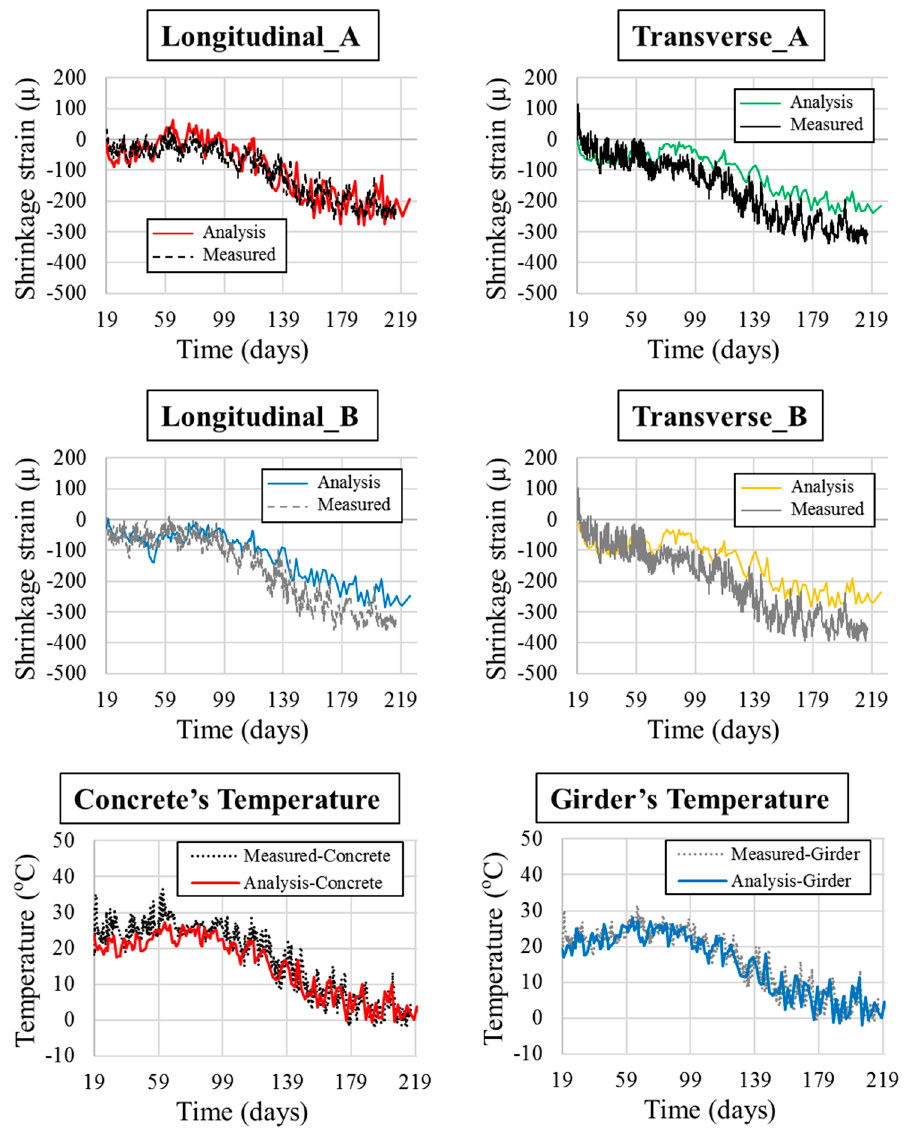
Figure 22. Concrete shrinkage strain at corresponding gauges and temperature of Shinkesen Bridge.